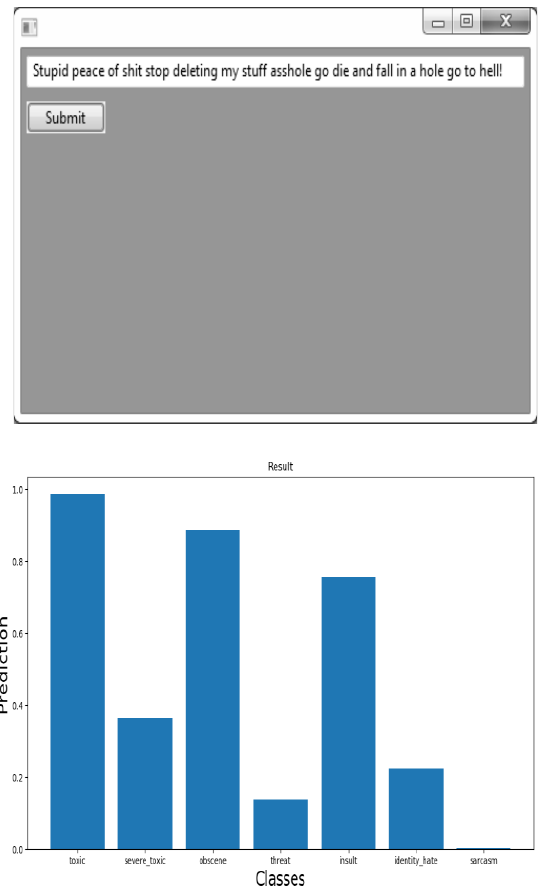
Fig.5 .GUI Based shaming category prediction using CNN.